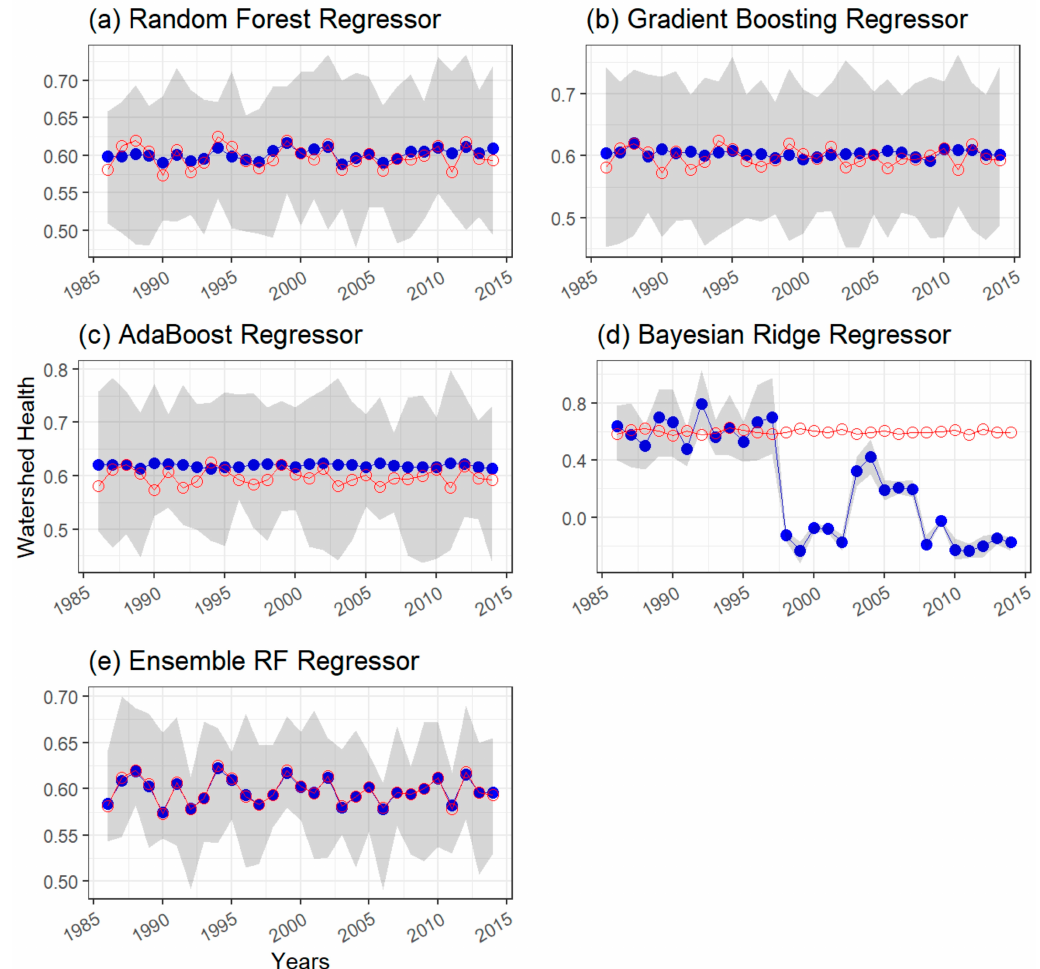
Figure 9. Same as Figure 5. Time series comparison of watershed health (with respect to orthophos- phate) estimated from observations as in Mallya et al. [48] at USGS-NAWQA station 04193500 Maumee River at Waterville, OH, which was part of the test set versus ML model predictions using ( a ) random forest regressor, ( b ) gradient boosting regressor, ( c ) AdaBoost regressor, ( d ) Bayesian ridge regressor, and ( e ) ensemble RF regressor.